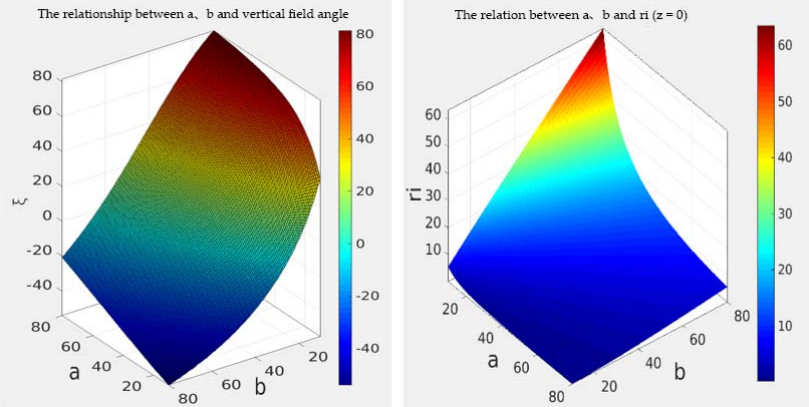
Figure 3. a, b and vertical field angle ξ relationship (left) and the relationship between a, b and ri vertical field angle (right).